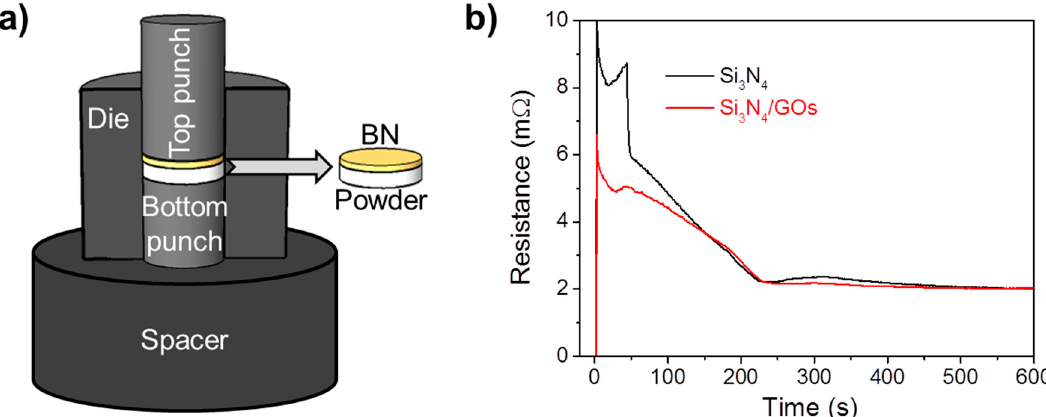
Figure 1. ( a ) Sketch illustrating the SPS set-up with the bottom punch fully enclosed into the die and leaned on the spacer, and a BN slab placed between the top punch and the ceramic powder compact. ( b ) Electrical resistance versus the SPS time recorded during the heating ramp for the Si 3 N 4 /GOs powder composition and compared with data previously reported for Si 3 N 4 powders using the same SPS conditions [6].